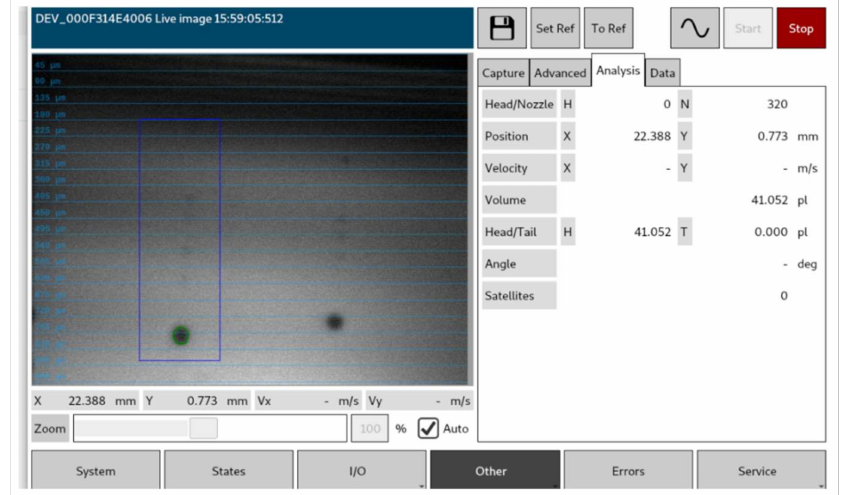
Figure 13. A dropwatcher of the Notion Systems machine characterizing in-flight